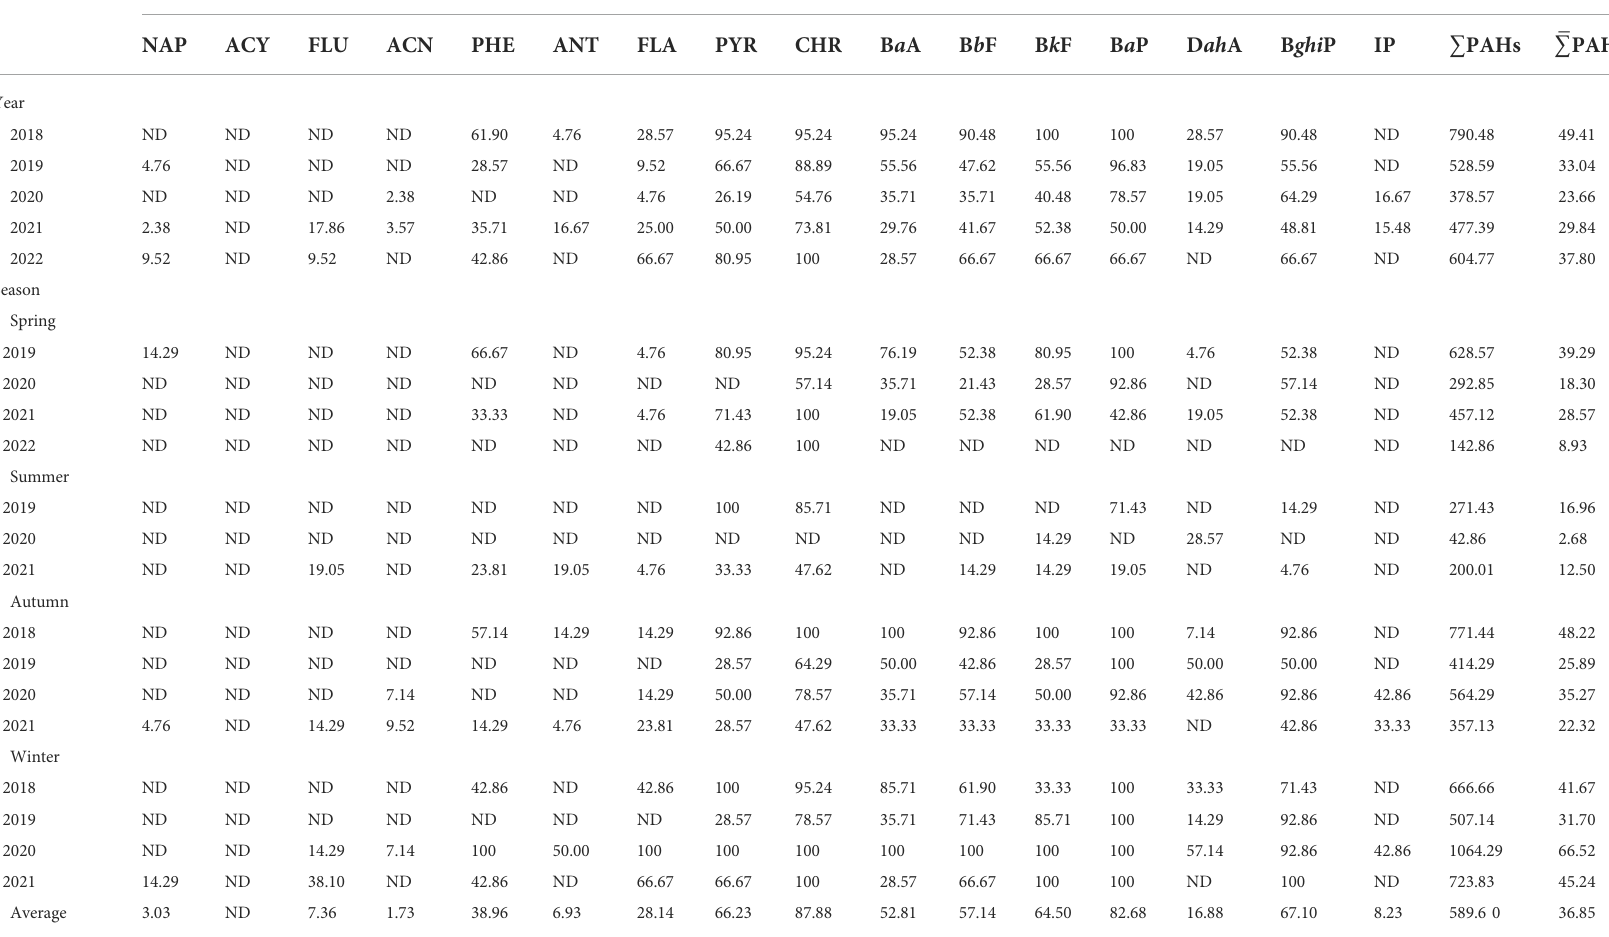
TABLE 3 Total and average detection rates (%) of 16 PAHs during the study period from 2018 to 2022.